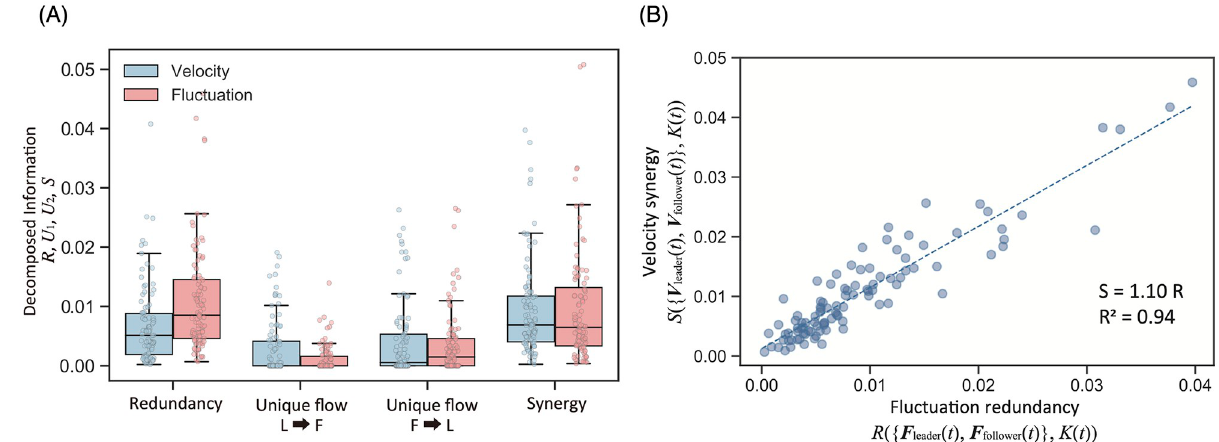
Fig 10. PID for group turning phase. (A) The PID decomposition for I V (blue) and I F (red) of the turning result in Fig 9C. The velocity synergy is higher than that of the redundancy (paired t -test: t (99) = 2.75, p < 0.01); however, the fluctuation synergy does not exceed the fluctuation redundancy (paired t -test: t (99) = − 0.934, p > 0.1). The other statistical test results are listed in S1 Table. (B) The relation between the velocity synergy S ({ V lead ( t ), V follow ( t )}; K ( t )) and fluctuation redundancy R ({ F lead ( t ), F follow ( t )}; K ( t )). The correlation efficient is 0.93 (Pearson’s correlation test: n = 100, p < 10 − 31 ). The other parameter settings are reported in S1